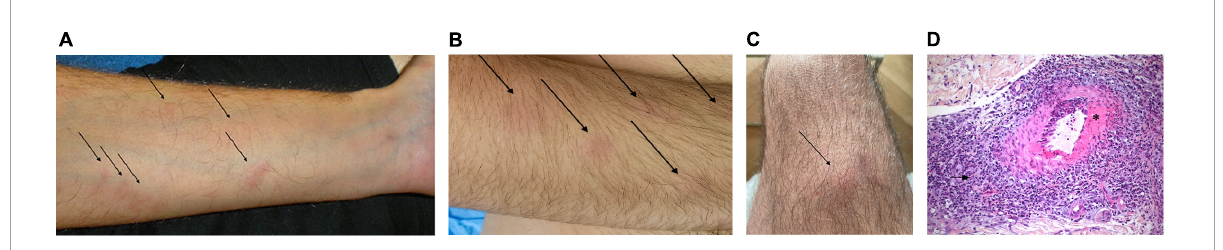
FIGURE1 Picture of lesion and pathology slide in patients with PAN and FMF (A–C) subcutaneous nodules. (D) Skin biopsy (Hematoxylin, eosin, and saffron staining; magnification × 200): Deep dermal small artery vasculitis with intimal fibrinoid necrosis ( ∗ ) and perivascular massive polymorphous inflammation of the adventice